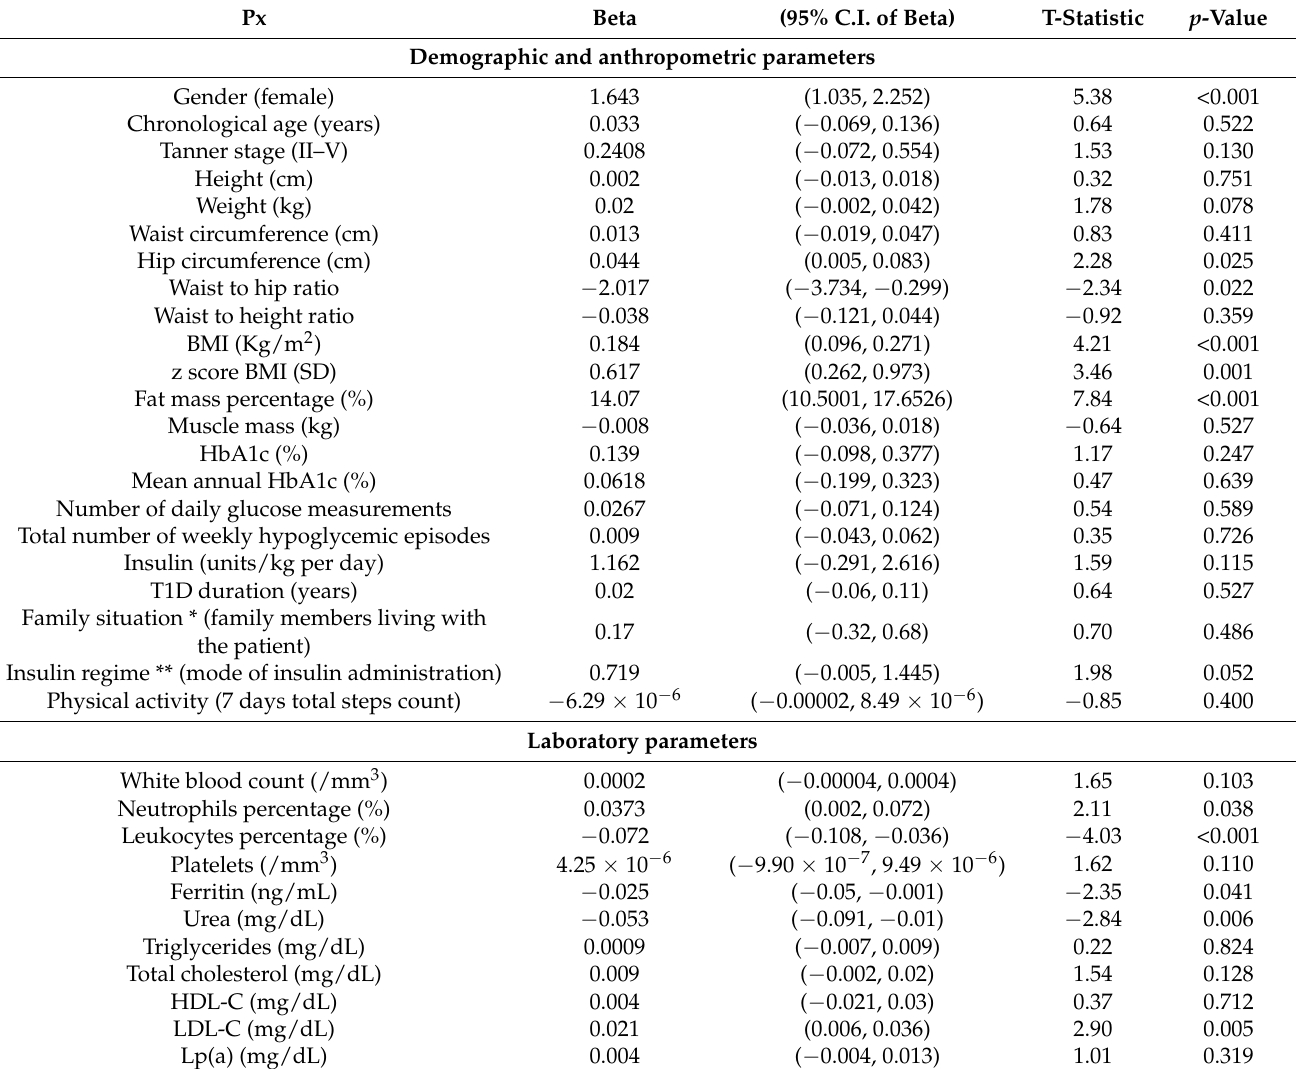
Table 3. Leptin correlations with basic demographic and physical and biochemical parameters with the use of univariant linear